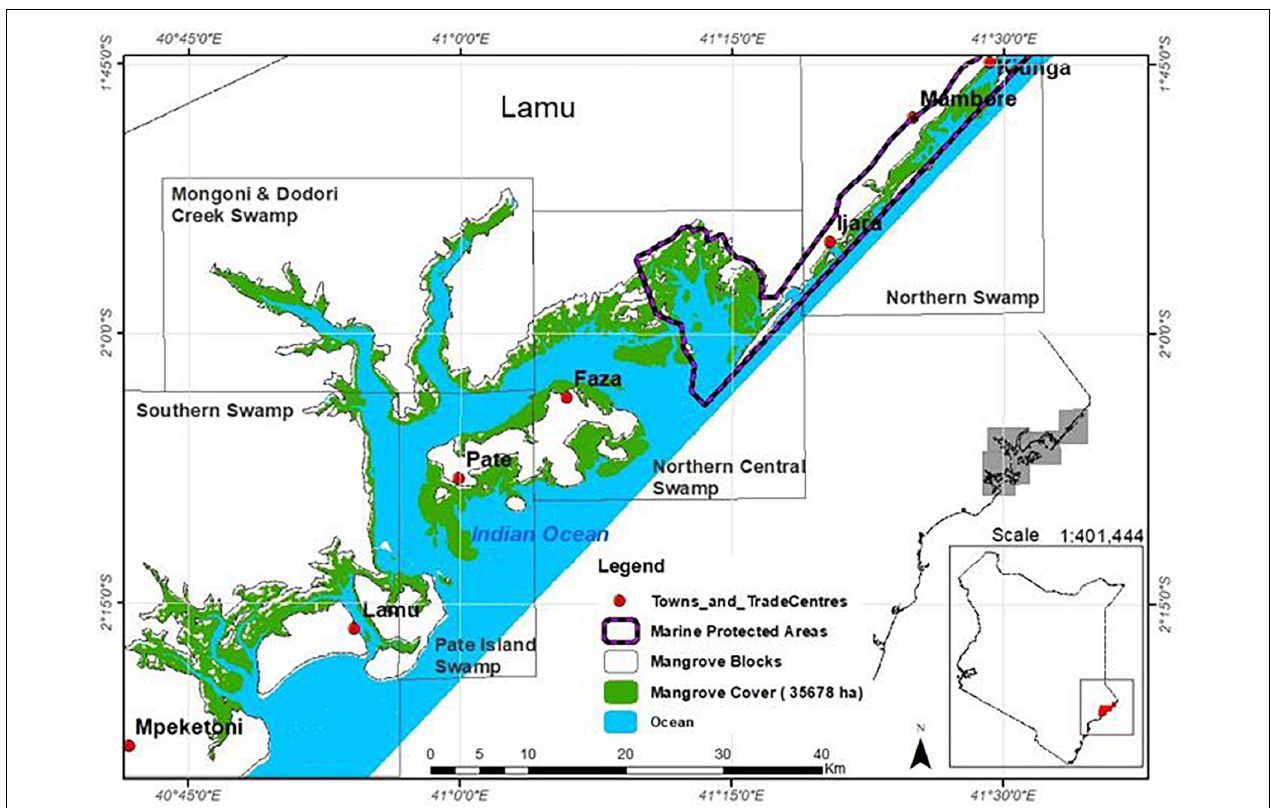
FIGURE 1 | Mangrove areas in Lamu County showing the management blocks.